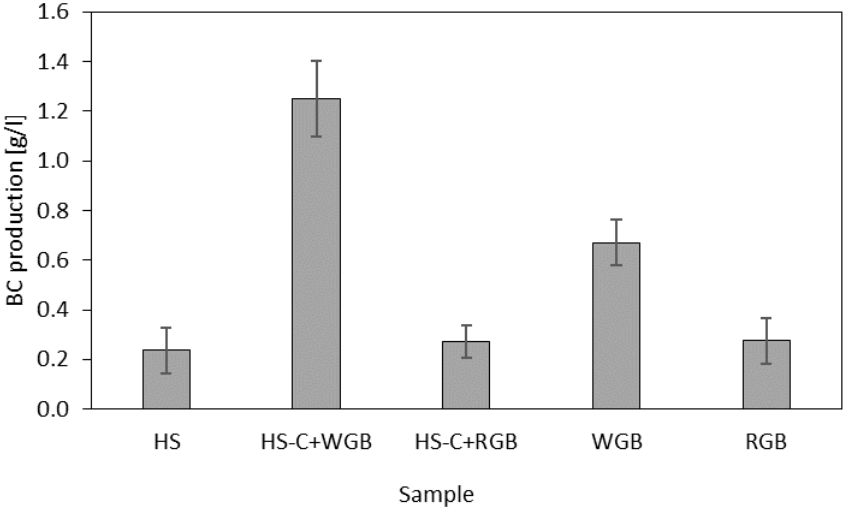
Figure 3. Bacterial cellulose production (g/L) in different culture media.